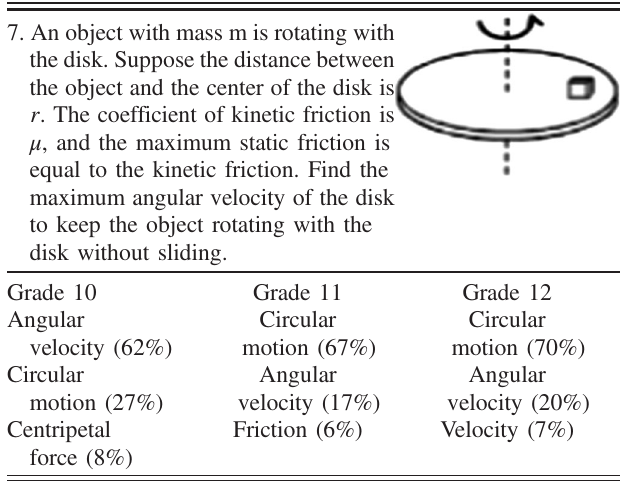
TABLE III. The percentage of the top 3 categories for Q15 created by the students in different grades.